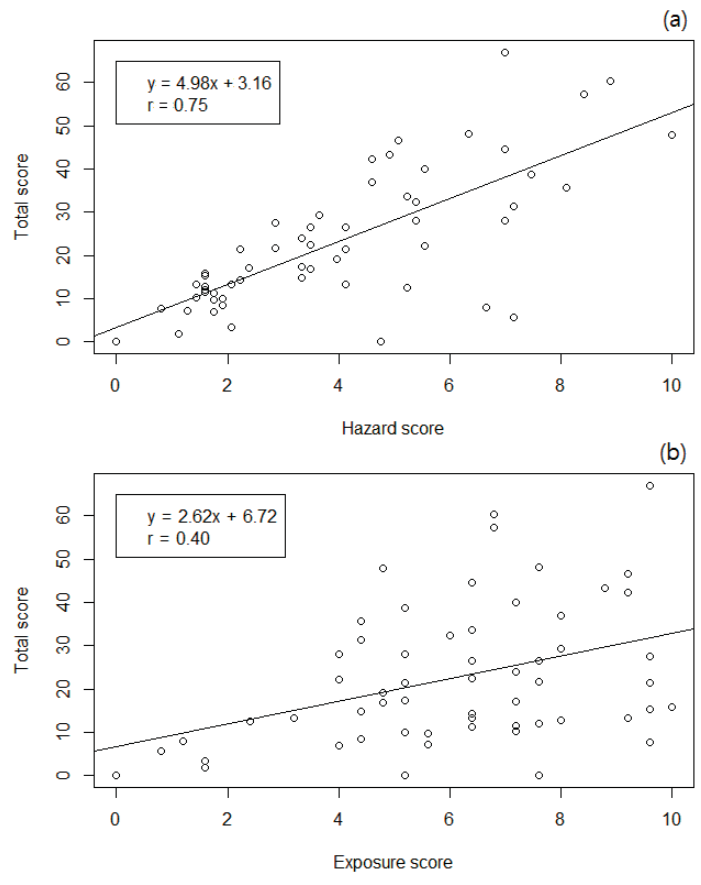
Figure 2. ( a ) The correlation between hazard score and total score; ( b ) The correlation between exposure score and total score; ( c ) The correlation between hazard score and exposure